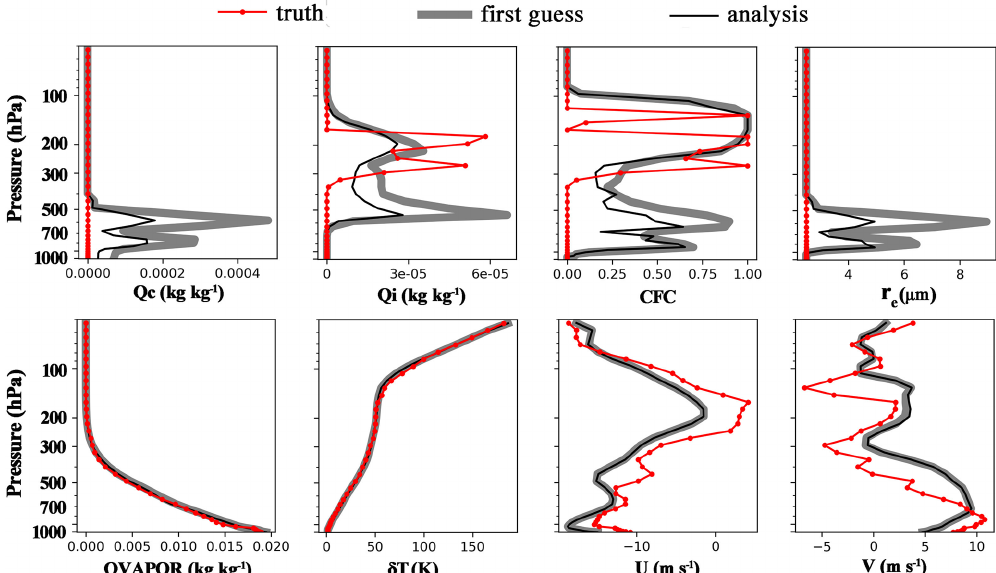
Figure 4. The vertical profiles of state variables for the nature run (theoretical truth), the first guess and analysis (ensemble mean). Q c denotes the liquid water mixing ratio, Q i the ice water mixing ratio, CFC the cloud fraction, r e the effective radius of liquid water droplets, QVAPOR the water vapour mixing ratio, δT the perturbation potential temperature, U and V the x - and y -wind